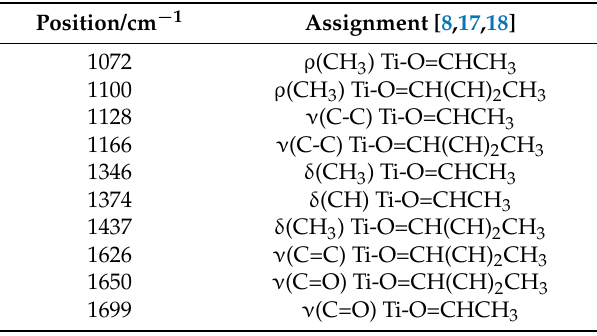
Figure 3. ATR-FTIR spectra recorded during the gaseous treatment of acetaldehyde in air over a TiO 2 film, for 2 h, under dry conditions, in the dark.